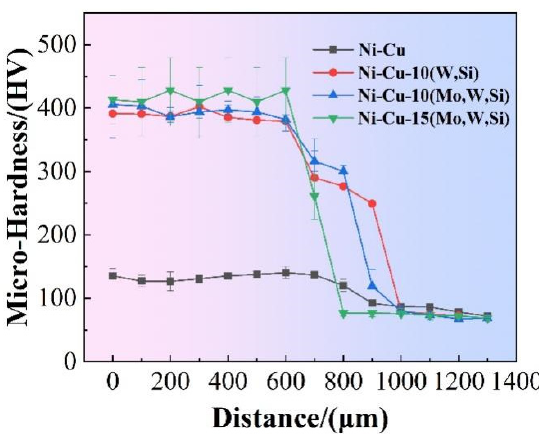
Figure 8. Micro-hardness graphs of four coatings.